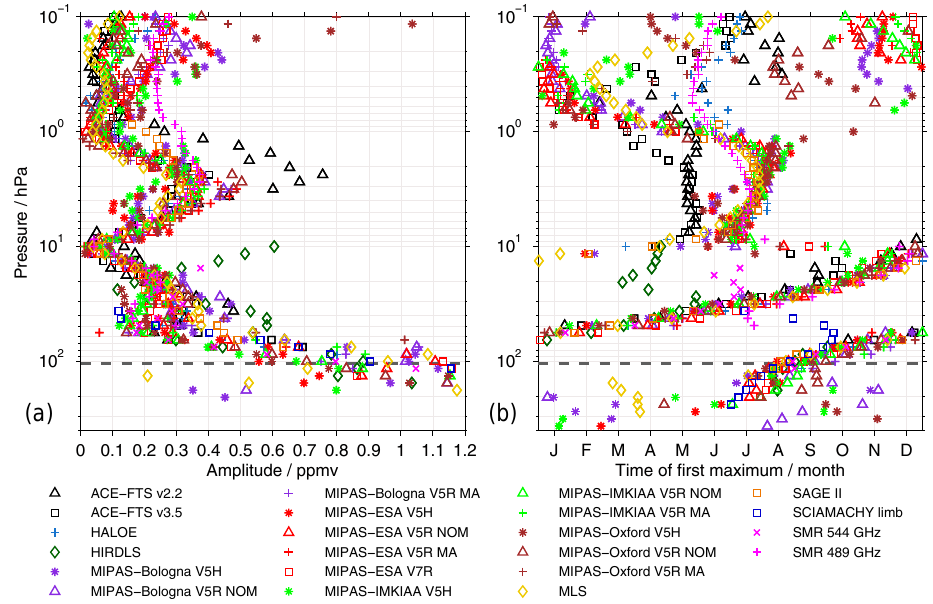
Figure 2. The annual variation in the inner tropics (5 ◦ S–5 ◦ N) as a function of altitude as seen by the different data sets. Like in Fig. 1 the left panel shows the amplitude of the variation while the right panel shows the phase. The dark grey dashed line indicates the mean tropopause for the latitude band, again using MERRA data for the time period 2000–2014. The ticks in the right panel refer to the centres of the individual